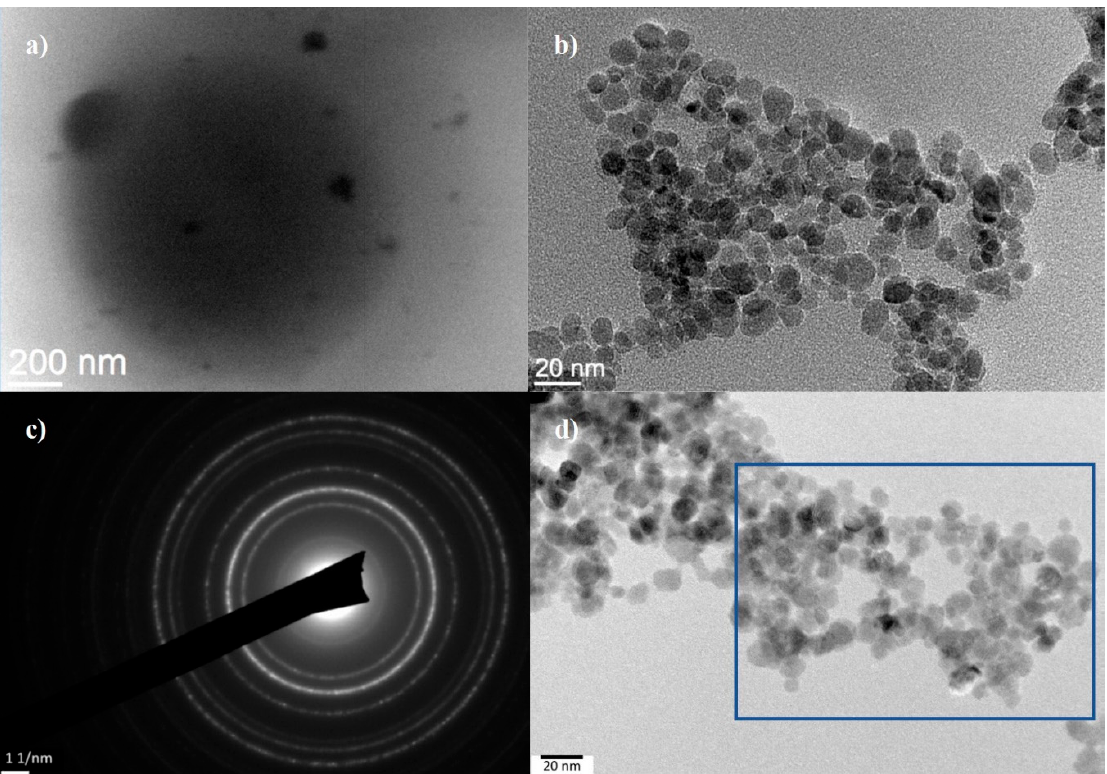
Figure 4. TEM images of ( a ) chitosan functionalized metal oxide microparticles using the microemulsion process (MC1), ( b ) chitosan functionalized metal oxide microparticles using the suspension cross-linking process (MC2), ( c ) the crystallinity of the nanoparticles and ( d ) chitosan functionalized metal oxide nanoparticles using the covalent binding method.